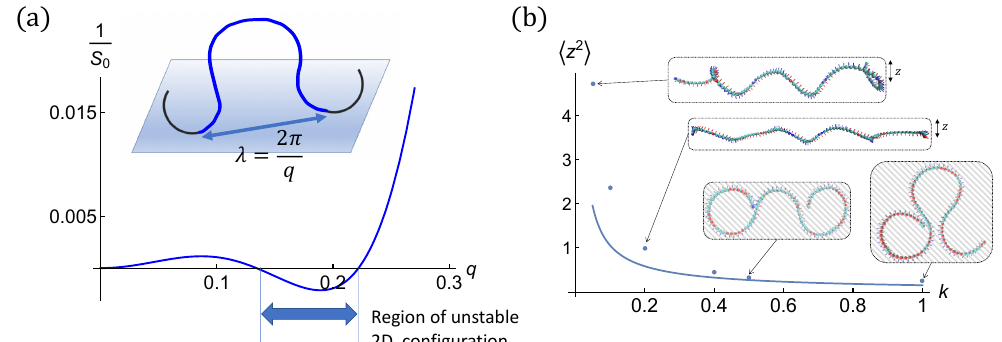
( q ) defined in Equation (10) (i.e., k = 0) for ω = 0.18 Figure 7. ( a ) The bare inverse structure factor S − 1 1 0 and ω 3 = 0.10. Boundary conditions impose flat circular shapes outside of the section of interest. Note the region of instability indicated by negative S − 1 . The harmonic potential of strength k would shift 0 ( q ) = S − 1 + k . Hence, k > 0.005 stabilizes the flat helical the inverse structure factor upwards by k , S − 1 0 k chain against small amplitude fluctuations. In practice, larger k is required to ensure the validity of the quadratic expansion. ( b ) The height fluctuation (cid:104) z 2 (cid:105) in weak fluctuation limits as a function of the stiffness f k of the harmonic potential for helical filament (i), ω 1 = 0.18 σ − 1 , ω 3 = 0.10 σ − 1 . Analytical calculation following Equation (11) is shown as solid line and the simulation data for filaments with one end anchored are shown in dots together with typical conformations at some k -values. Flat configurations at k = 0.5 and 1.0 are captured from the top